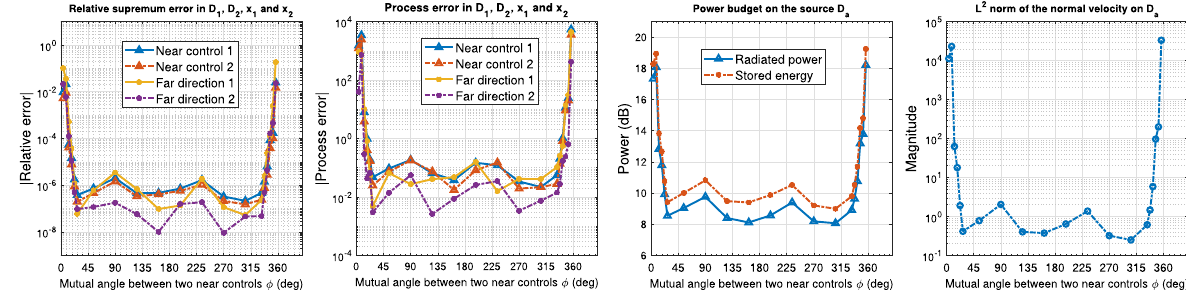
Figure 12. Results showing the control accuracy and the power budget varying with the mutual distance between near controls D 1 and D 2 (given as a function of the angle / between them). From left to right, (1) Supremum error. (2) Process error. (3) Power budget on D a . (4) L 2 norm of normal velocity v n on D a .